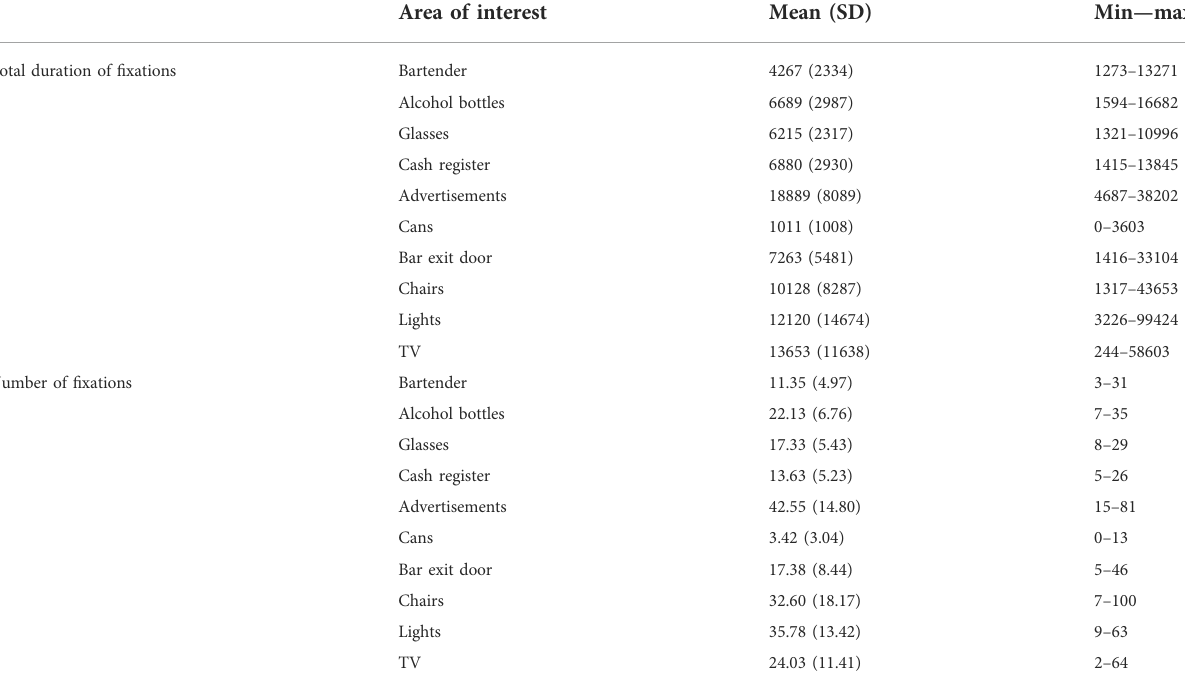
TABLE 3 Means, standard deviations, minimums, and maximums for eye tracking data for alcohol-related and neutral